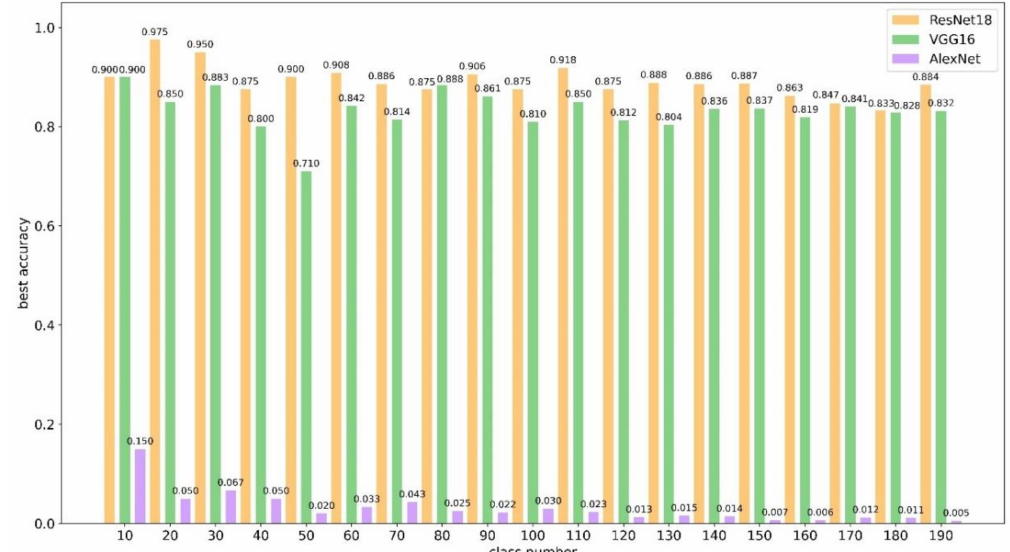
Figure 6. Accuracy of three different face classifiers without transfer